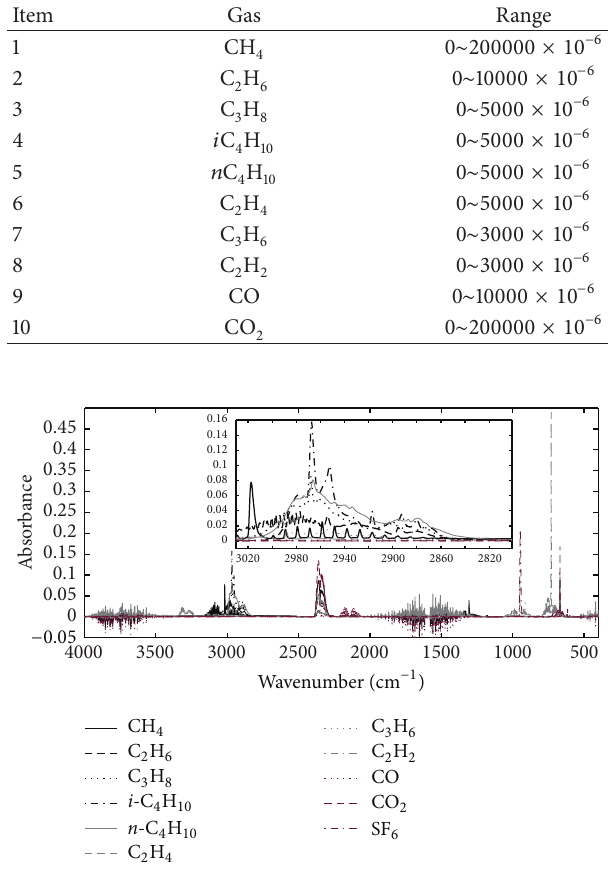
Figure 1: Absorption spectra of index gases of spontaneous com- bustion of